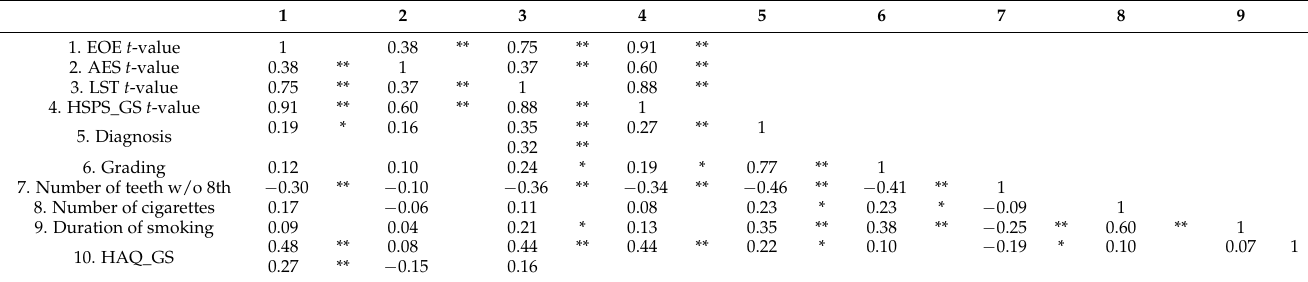
Table 4. Bivariate correlations of sensitivity (SPS), HAQ, diagnosis of periodontitis, and risk factors ( n = 116).